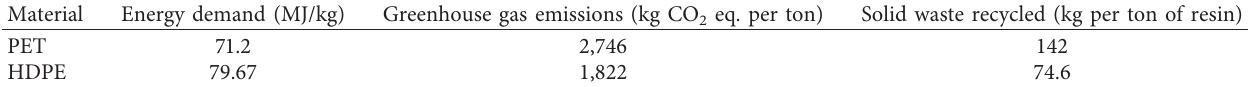
Table 8: Virgin resin data for PET and HDPE production [37].